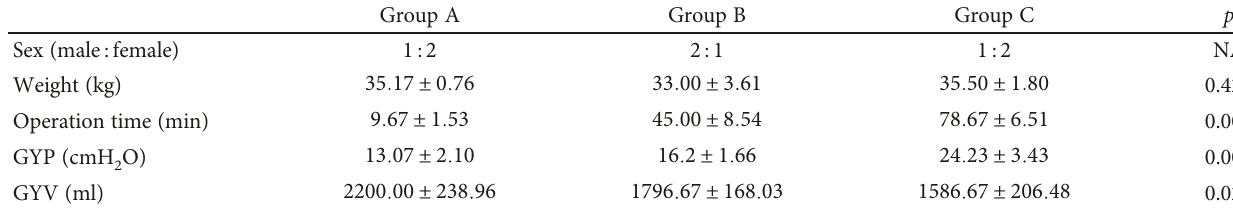
Table 1: The clinical characteristics, GYP, and GYV of